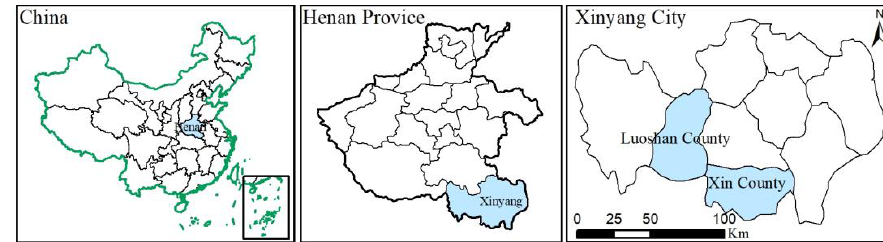
Figure 2. Location of the study